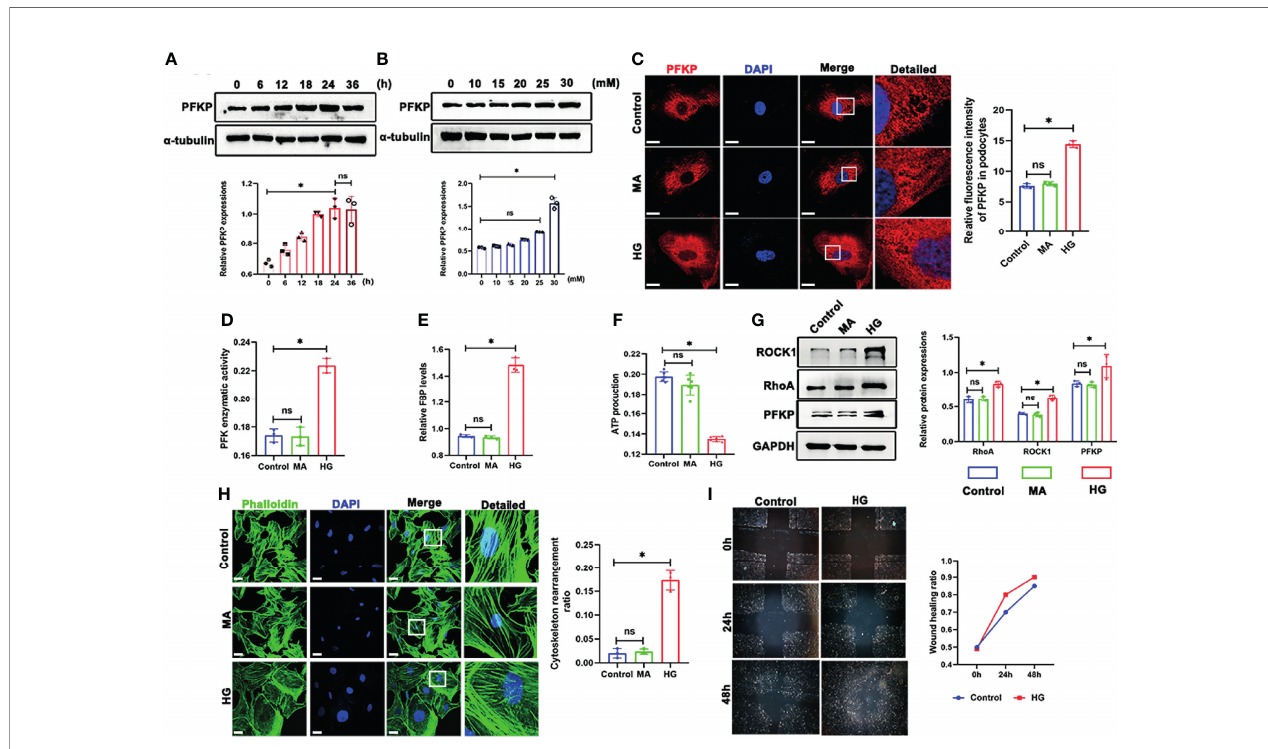
FIGURE 5 | High glucose promoted PFKP expression and cytoskeletal remodeling in podocytes in vitro . (A) Representative western blots of PFKP expression in 30 mM HG-treated podocytes at various times points and quanti fi cation of these results, with a -tubulin as the loading control. (B) Representative western blots of PFKP expression in cultured podocytes stimulated with different concentrations of glucose for 24 h and quanti fi cation of these results, with a -tubulin set as the loading control. (C) Representative immuno fl uorescence staining of podocytes PFKP in each group. (D) PFK enzymatic activity in each group. (E) FBP level in each group. (F) ATP production in each group. (G) Western blotting analyses of the expression of ROCK1, PFKP and RhoA in podocytes in each group. GAPDH was set as the loading control. (H) Cytoskeletal structures of podocytes labeled with phalloidin. (I) Motility of podocytes quanti fi ed by a wound-healing assay using an inverted microscope. For all fi gures, n=3 independent experiments/group. * P < 0.05, ns, No signi fi cance. Scale bars: 10 µm. HG, high glucose; MA, mannitol; ROCK1, Rho- associated, coiled-coil containing protein kinase 1; PFKP, phosphofructokinase 1 platelet type; RhoA,